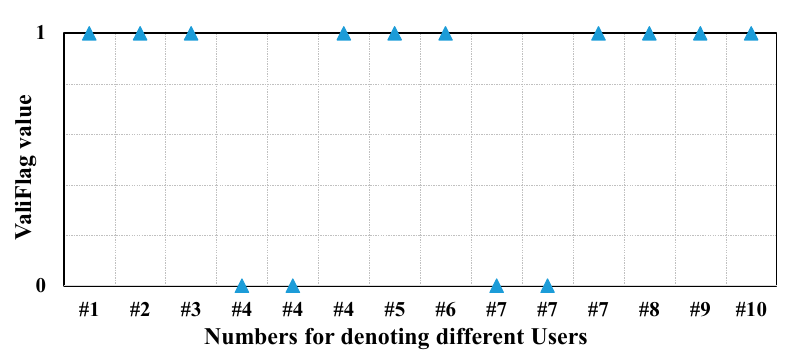
Figure 11. ValiFlag value for the access operation of each device.